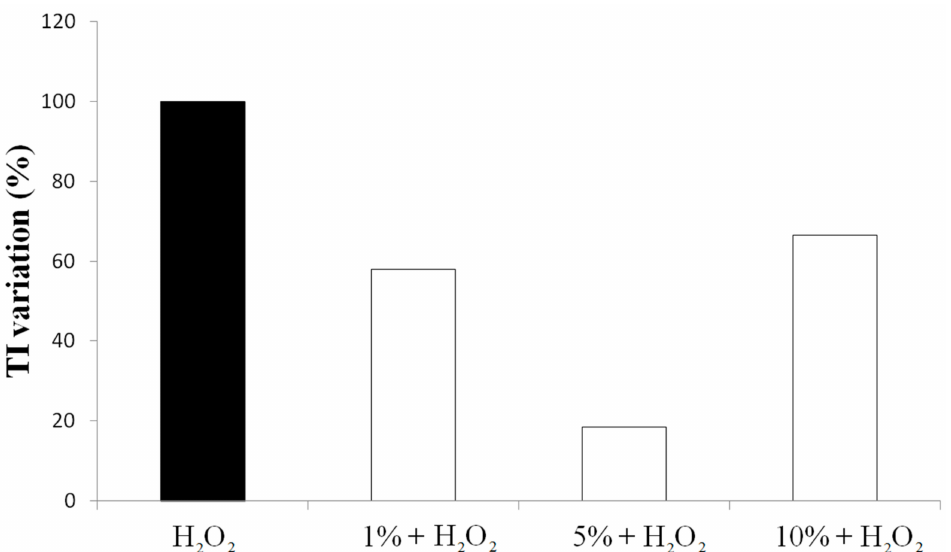
Figure 2. Antioxidant activity of spinach juice on HT29 colon cancer cells. Antioxidant activity has been evaluated by Comet assay on HT29 cells after 24 h of treatment with spinach juice from normoxic plants at different concentrations (1%, 5%, and 10%) and 5 min of H 2 O 2 (100 µ M) stress. On the y -axis, the Tail Intensity (TI) variation (%): (TI sample + H 2 O 2 /TI H 2 O 2 ) x 100 is reported. In particular, the 1% juice solution shows a reduction of 40% of DNA migration. The 5% juice shows the highest antioxidant activity with a reduction of the 80% of DNA damage. The 10%